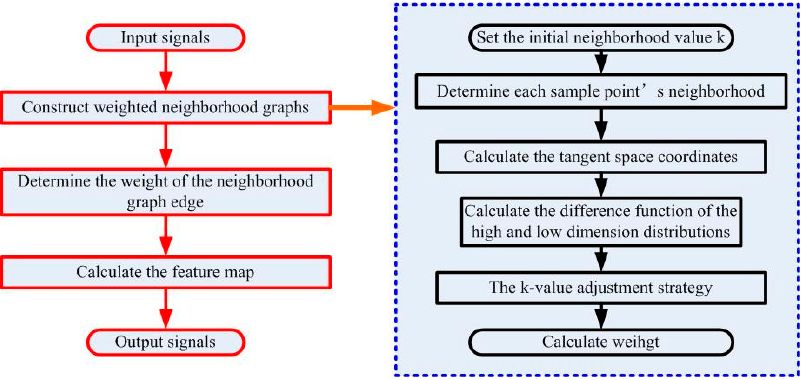
Figure 2. Diagram of the steps in the method.